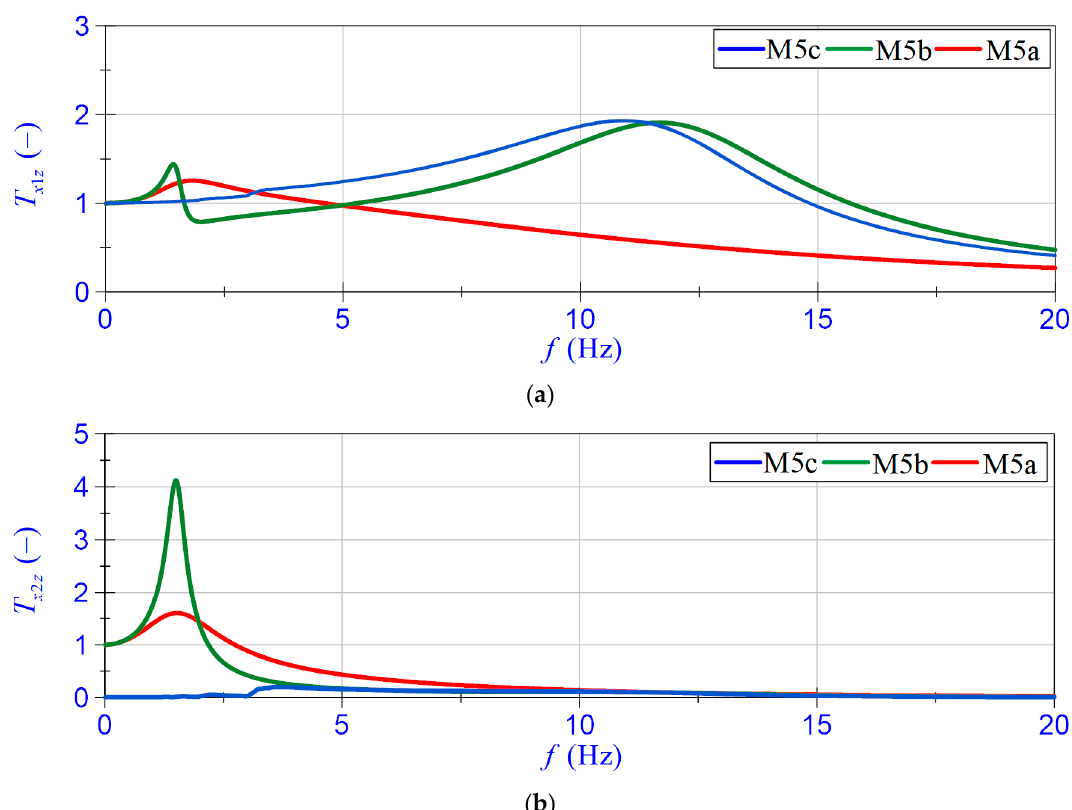
Figure 6. Displacement transmissibility coefficients: ( a ) T x 1 z ; ( b ) T x 2 z —semiactive and active suspen- sion system.